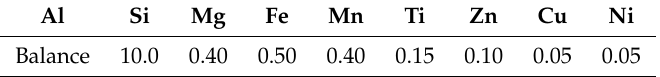
Figure 1. Schematic of an overhang specimen. Table 1. The chemical components of AlSi10Mg powder (wt %).